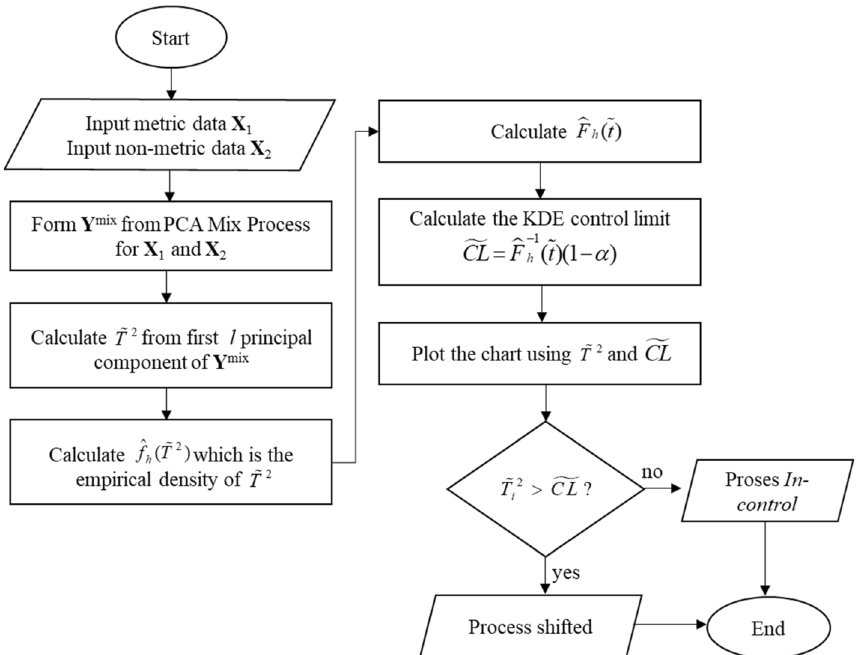
Figure 1. Procedures of PCA Mix